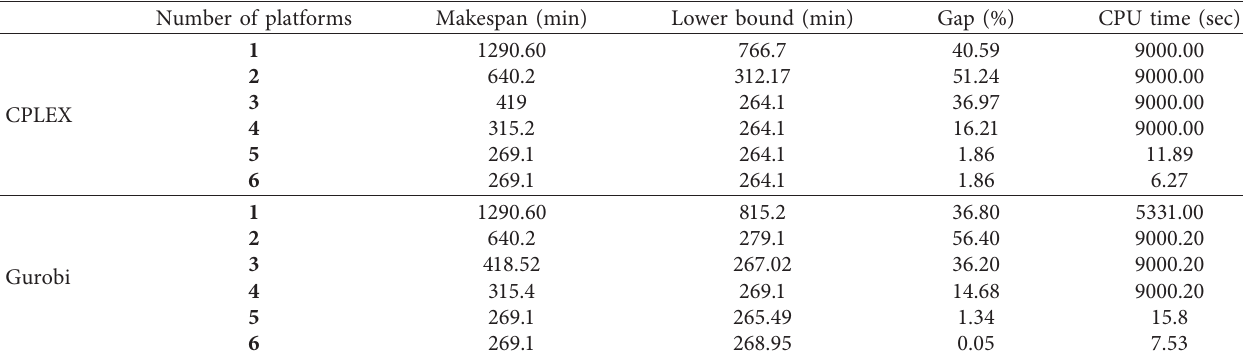
Table 2: Obtained results for the future scenario B